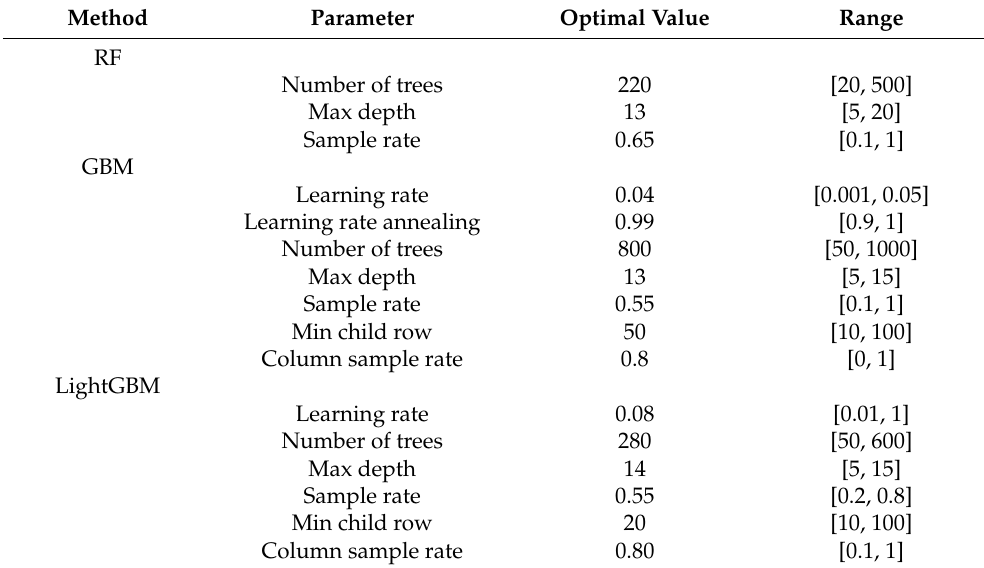
Table 2. Hyperparameters.